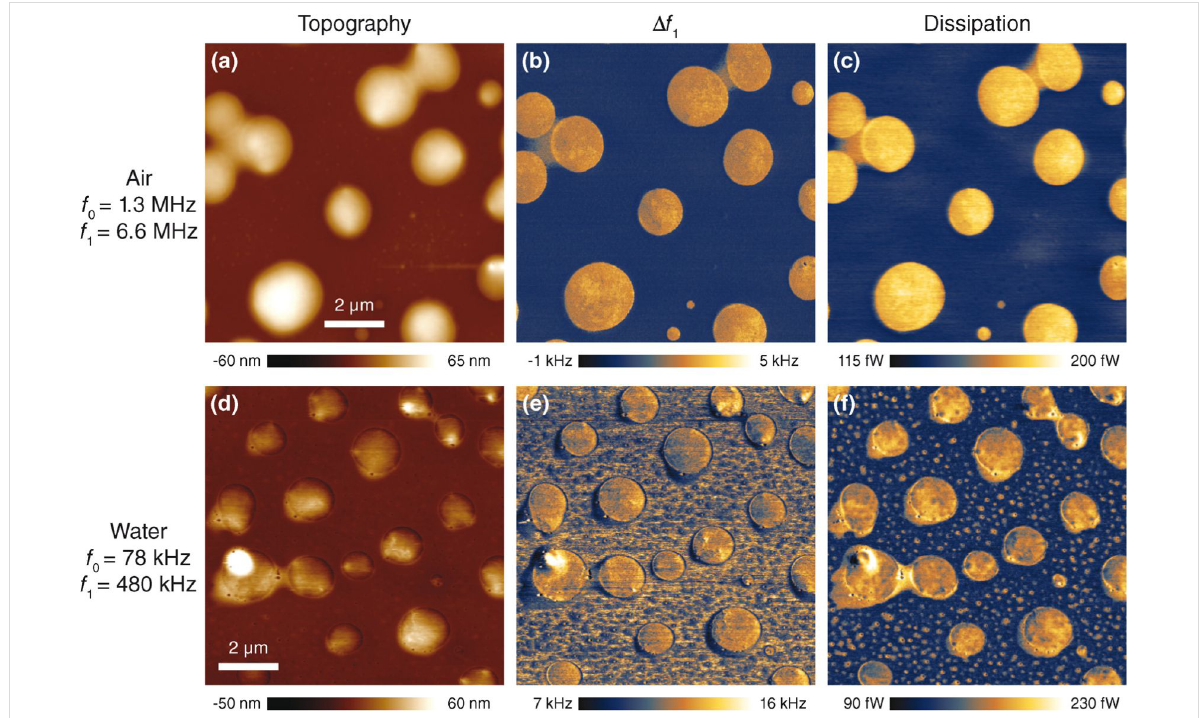
Figure 4: Bimodal AFM imaging of a PS/PMMA polymer blend with small, high-frequency cantilevers in both air (panels a–c) and water (panels d–f). Panels a and c show topography based on amplitude modulation of the fundamental resonance. Panels b and e show the resonance frequency shift of the first higher resonant mode, and panels c and f show the drive amplitude needed to keep the first higher resonant mode at constant amplitude, related to the energy dissipation in the tip–sample